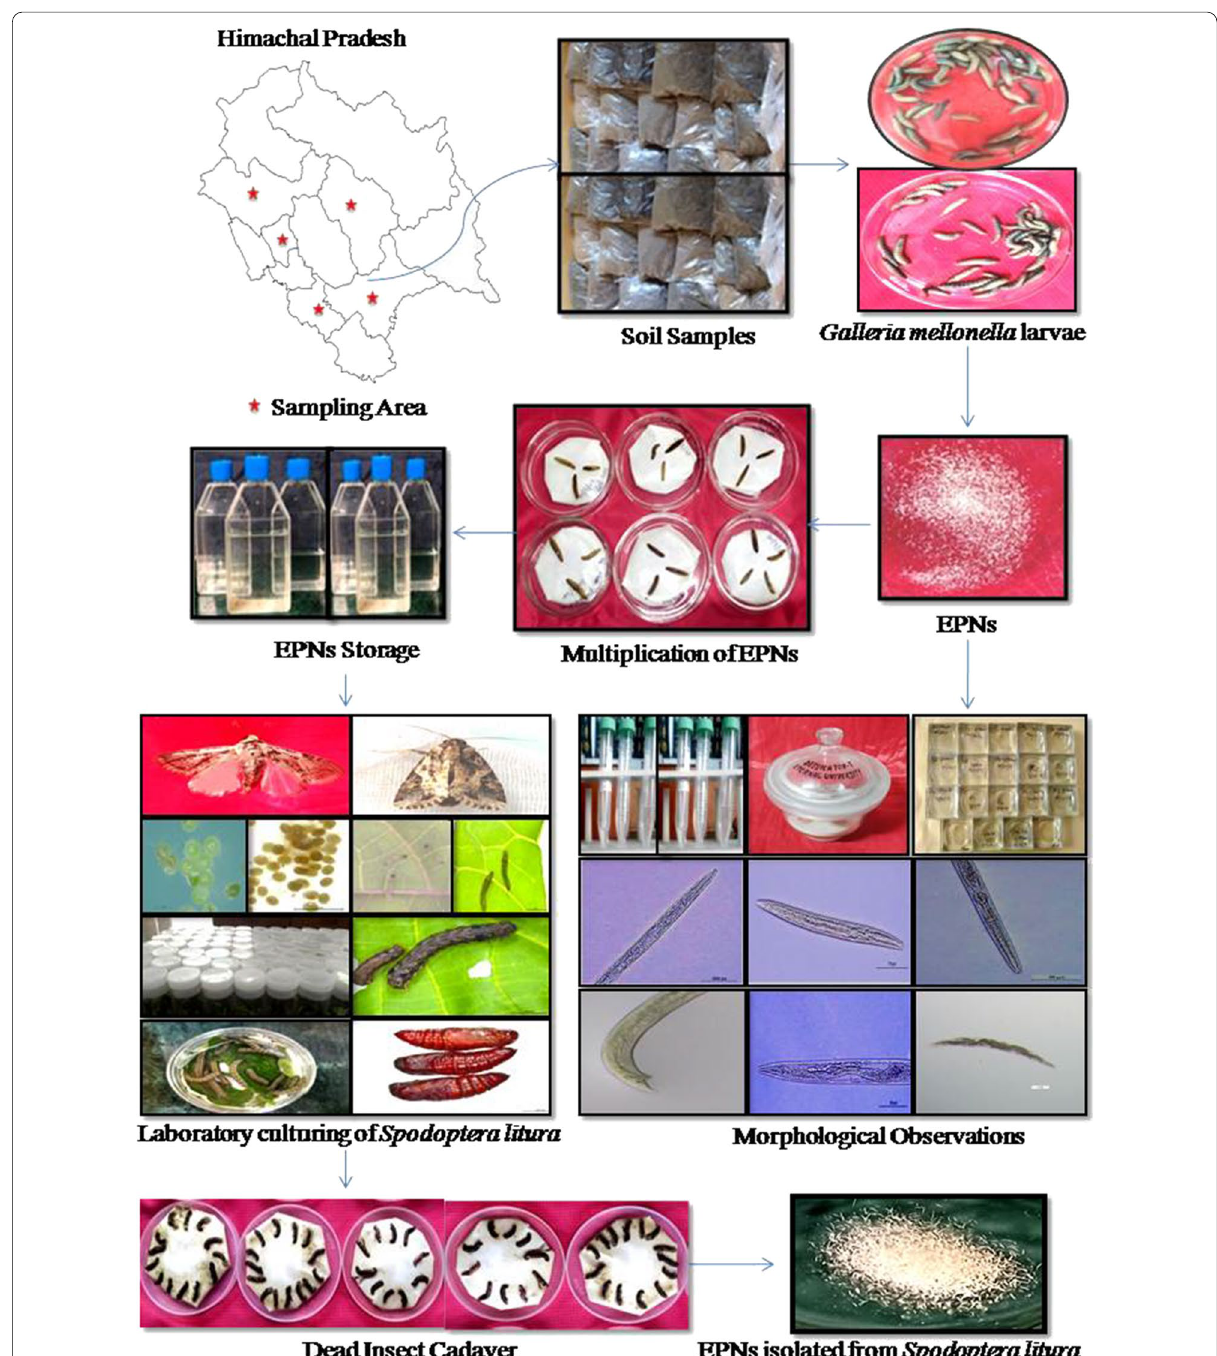
Fig. 1 Isolation, identification and bioassay of entomopathogenic nematode strains in the